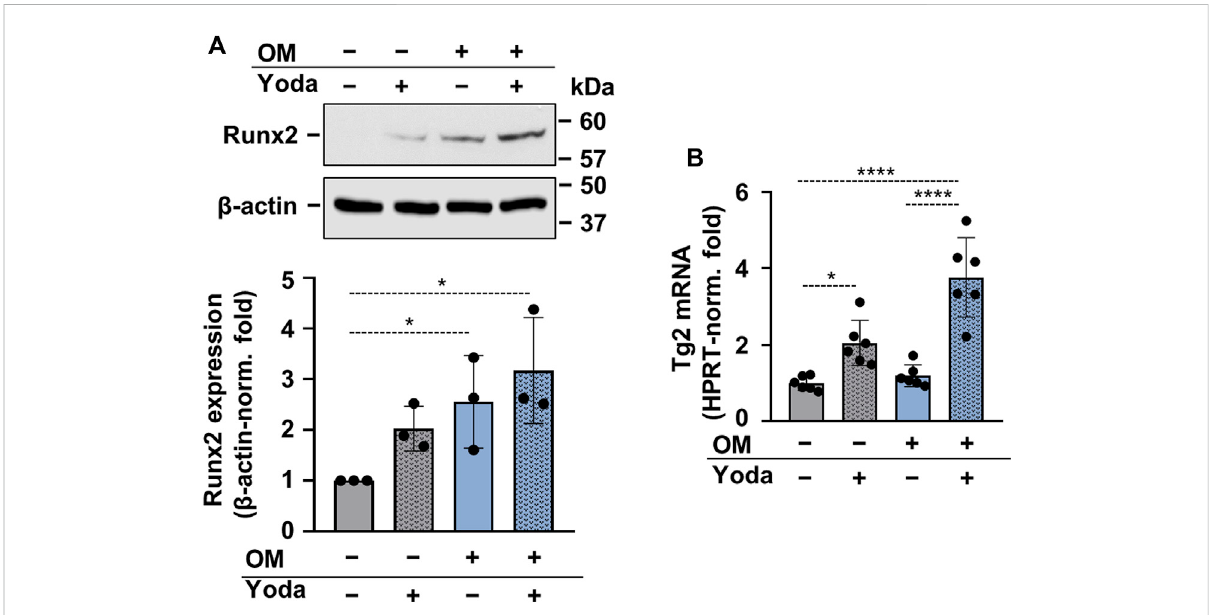
FIGURE 4 Upregulation of Runx2 and Transglutaminase 2 (Tg2) in calcifying HAoSMCs (A,B) HAoSMCs were exposed to Yoda1 (10 μ mol/L), OM (OM; excess P i : 1.5 mmol/L, excess calcium: 0.6 mmol/L) or OM + Yoda1. (A) Protein expressions of Runx2 and β -actin were determined from whole-cell lysates (12 h). Representative Western blots out of three. β -actin-normalized relative expression of Runx2. (B) Tg2 mRNA levels were determined by